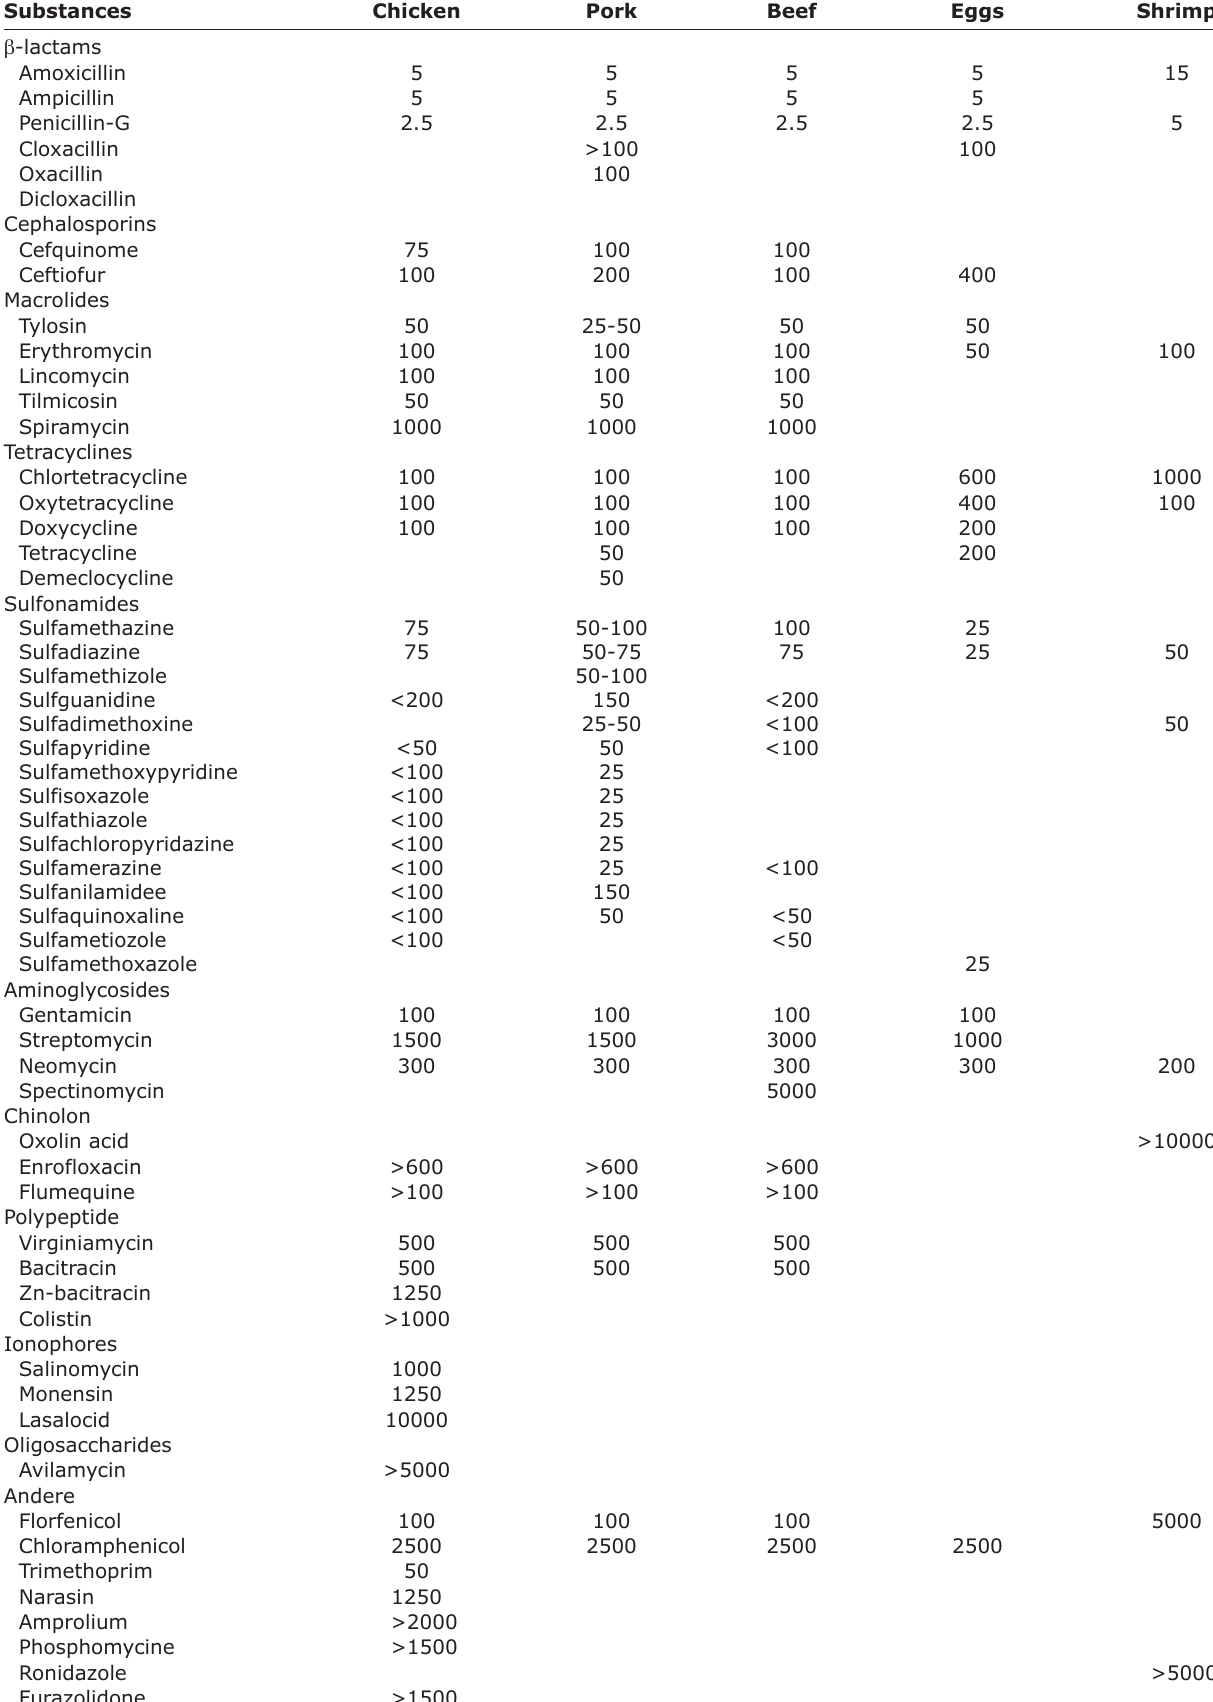
Table-1: Premi® Test detection limits in different animal food products.